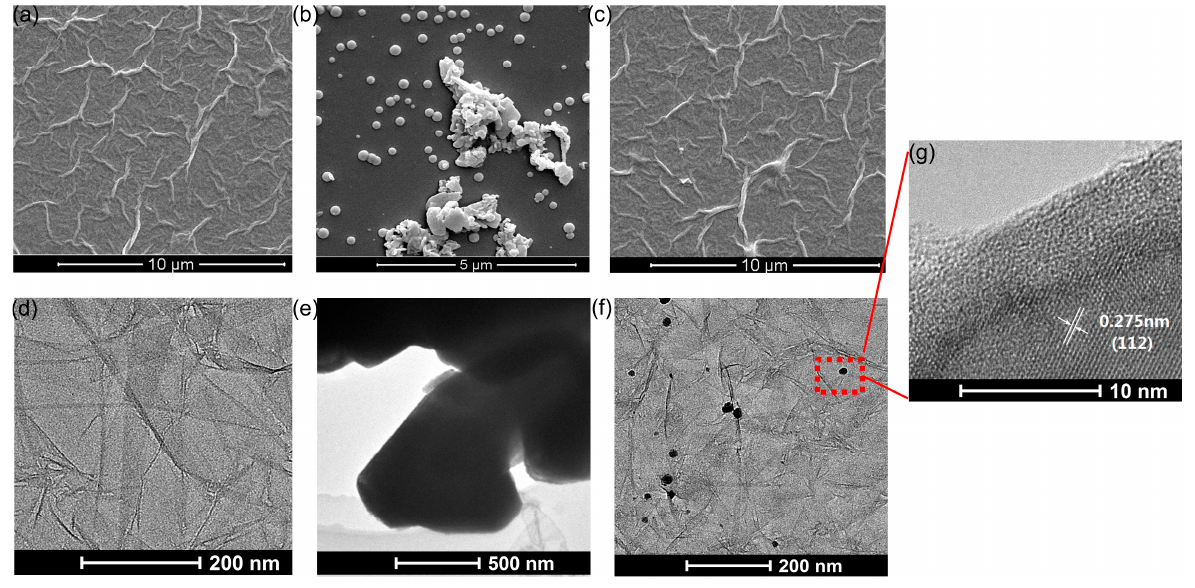
Figure 3. SEM ( a–c ) and TEM ( d–f ) images of GO, MoTe 2 , and GO/MoTe 2 . ( g ) HRTEM image of Figure 3. SEM ( a – c ) and TEM ( d – f ) images of GO, MoTe 2 , and GO/MoTe 2 . ( g ) HRTEM image of GO/MoTe 2 GO/MoTe 2 .